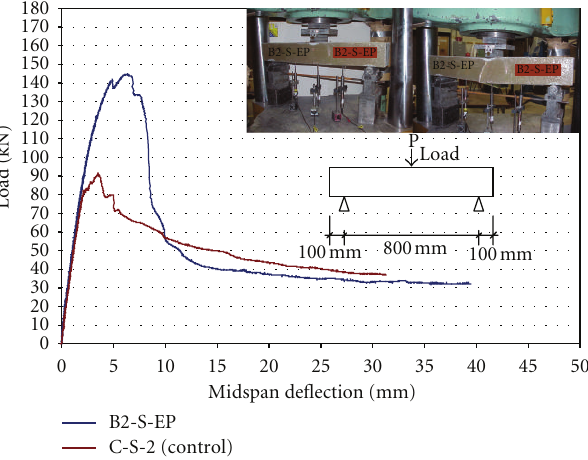
Figure 14: Load versus midspan deflection of RC beam B2-S-EP.